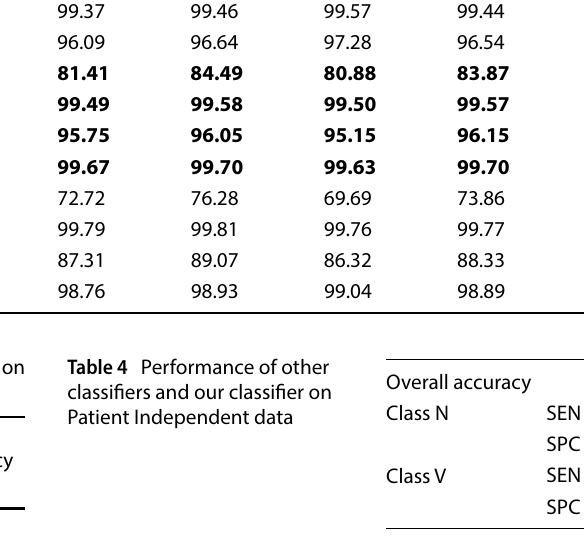
Table 2 Performance of the Stacked RBM classifier for Patient Independent Data